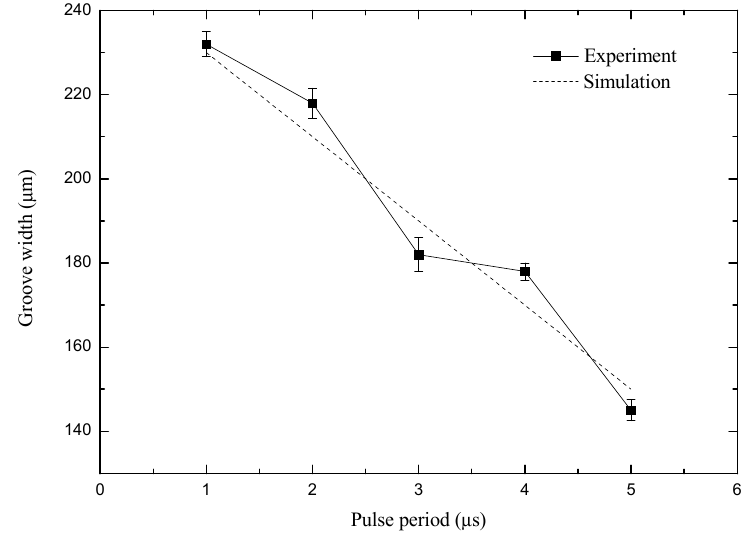
Figure 12. Curve of groove width with the pulse period.